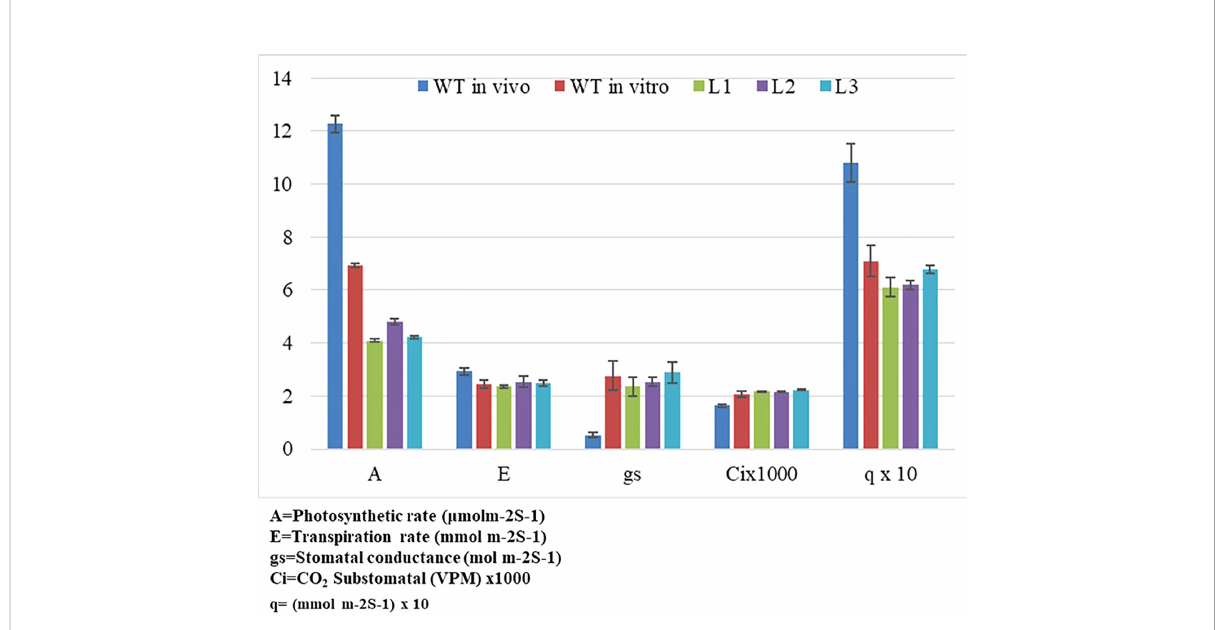
FIGURE 7 Impact assessment of ycf4 deletion on physiological performance of transplastomic Δ ycf4 and wild-type (WT) tobacco plants. WT represents Wild-type whereas L1, L2, and L3 represent 1st, 2 nd , and 3rd leaf of Δ ycf4 plants from top to bottom,